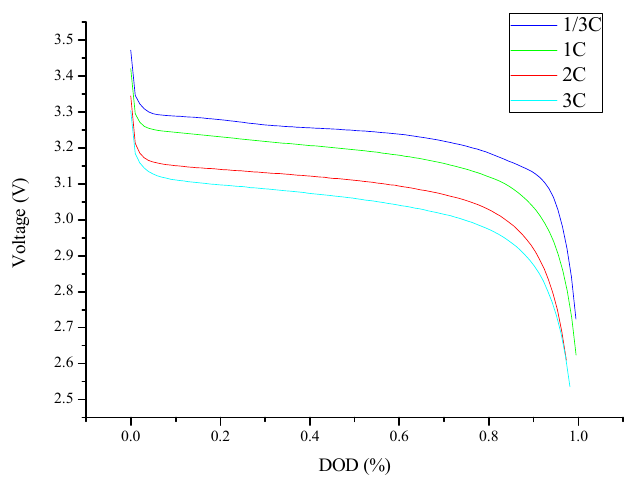
Figure 2. Voltage vs. depth of discharge (DOD) curves for different rates.